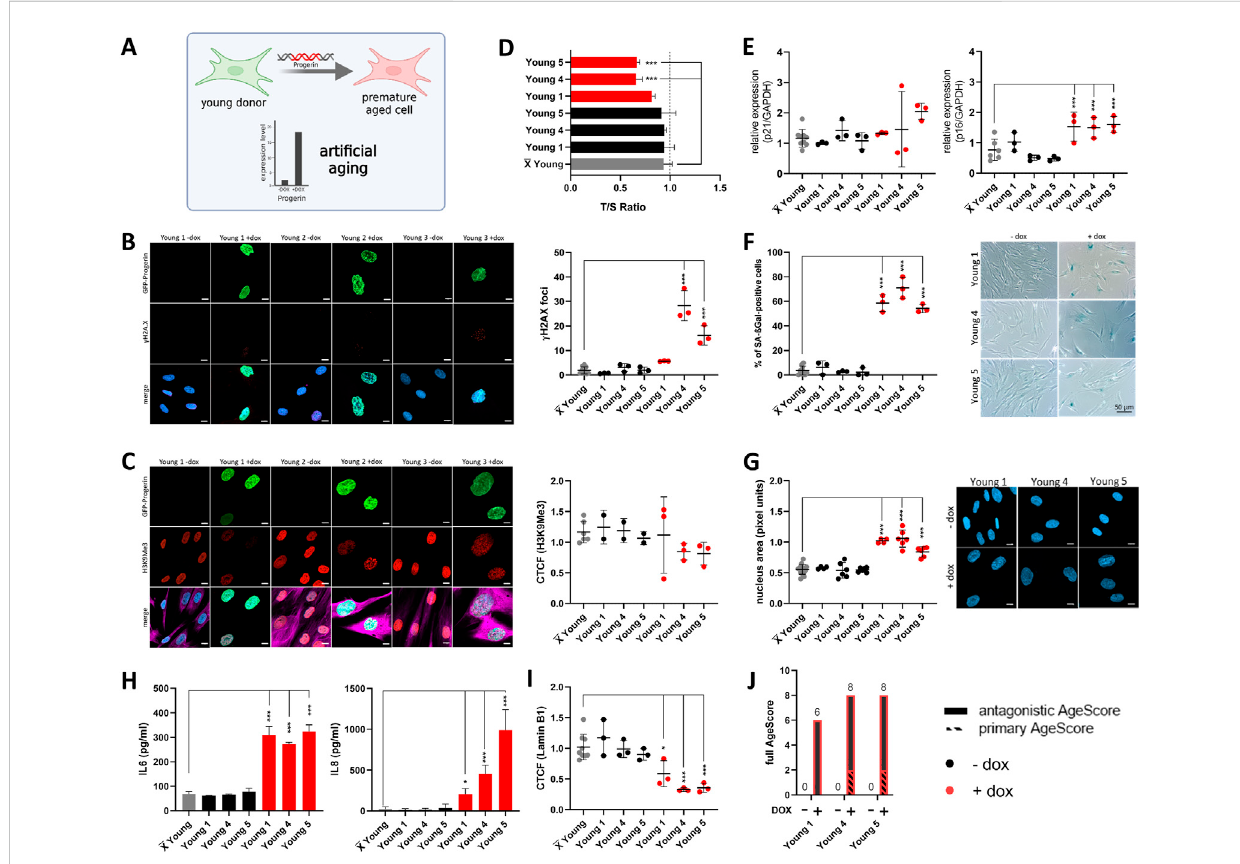
FIGURE 5 Examination of the AgeScore in premature aged human fi broblasts of young donors. Data for prematurely aged fi broblasts (induced with Doxycyclin) are marked in red. (A) For validation of the proposed AgeScore, young donor fi broblasts were premature aged by dox-inducible Progerin overexpression. (B) Representative IF images of γ H2A.X and GFP-Progerin signal in absence and presence of doxycycline (1 μ g/mL) after 4 days. Amount of γ H2A.X foci per cell increased in cell lines with GFP-Progerin expression (Young 4, Young 5) in comparison to non-induced fi broblasts. [ n = 3 (each n tested > 15 cells), mean ± SEM,* p < 0.05, ** p < 0.001, ***p < 0.0001, one-way ANOVA, scale bar = 10 µM] (C) Representative IF images of H3K9Me3andGFP-Progerinsignalinabsenceandpresenceofdoxycycline(1 μ g/mL)after4 days(mergeincludesmagenta=Vimentin).CTCFdisplayed no change in prematurely aged young donor of H3K9Me3 [ n = 3 (each n tested > 15 cells), mean ± SEM,* p < 0.05, ** p < 0,001, ***p < 0.0001, one-way ANOVA, scale bar = 10 µM] (D – I) X (cid:1) = Mean value of all young donors. (D) Telomere length was measured by MM-qPCR in comparison to a standard of healthy mixed aged individuals. In comparison to non-induced cells, Young 4 and Young 5 with progerin expression displayed a shorting of telomere length. [ n = 3, mean ± SEM, * p < 0,05, ** p < 0.001, ***p < 0.0001 , one-way ANOVA] (E) RNA expression levels by qRT-PCR of p21 and p16 was measured to investigate activation of cell cyclearrest inhuman fi broblasts.Young 1,Young 4 andYoung5 with progerin expression displayed araise ofrelativeRNA expression level of p16 in comparison to non-induced controls. [ n = 3, mean ± SEM * p < 0.05, ** p < 0.001, ***p < 0.0001 , one-way ANOVA] (F) Representative IF images and quanti fi cation of SA- β GAL positive cells by X-Gal staining. All three young donor cell lines with induced GFP-Progerin expression showed an increase in amount of positive stained SA- β GAL cells. [ n = 3 (each n tested > 15 cells), mean ± SEM, * p < 0.05, ** p < 0.001, ***p